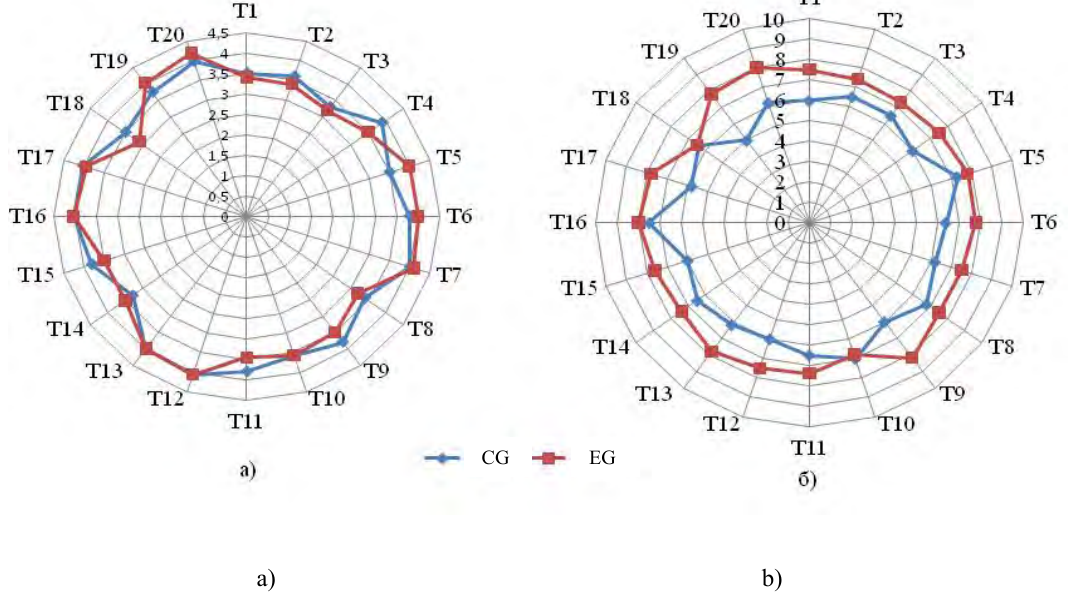
Fig.1. Dynamic of general physical and technical fitness of control and experimental groups’ female gymnasts